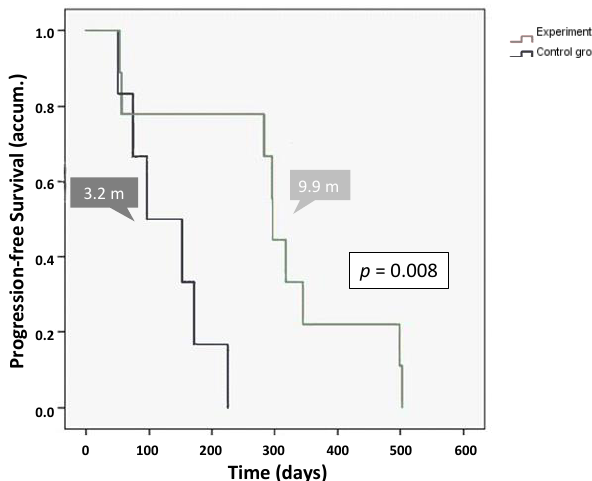
Figure 5. Radiological time to progression analysis by treatment group.